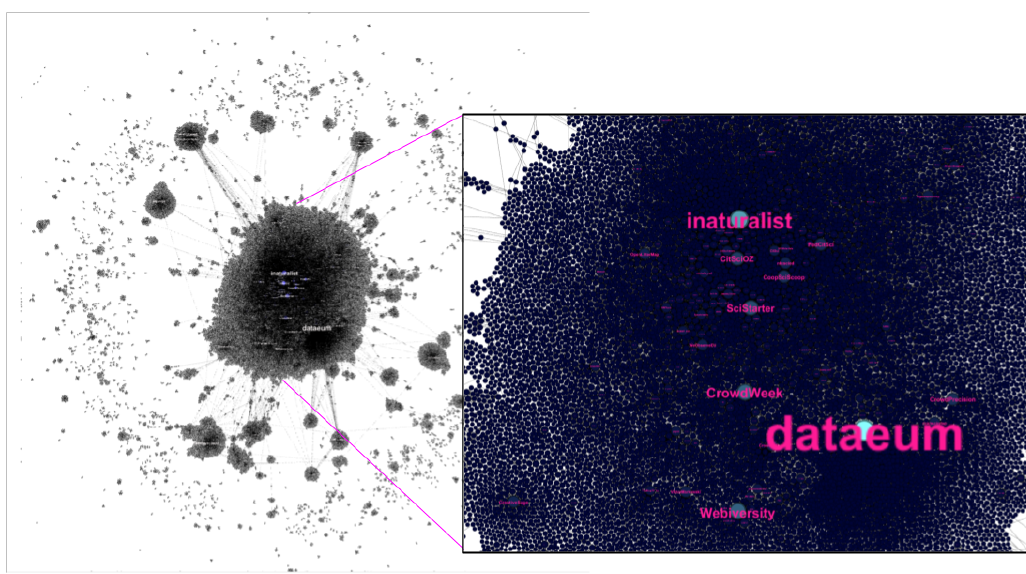
Figure 10. Visualising a more zoomed-in view of the inner core showing the strong network connections with several organisations acting as key